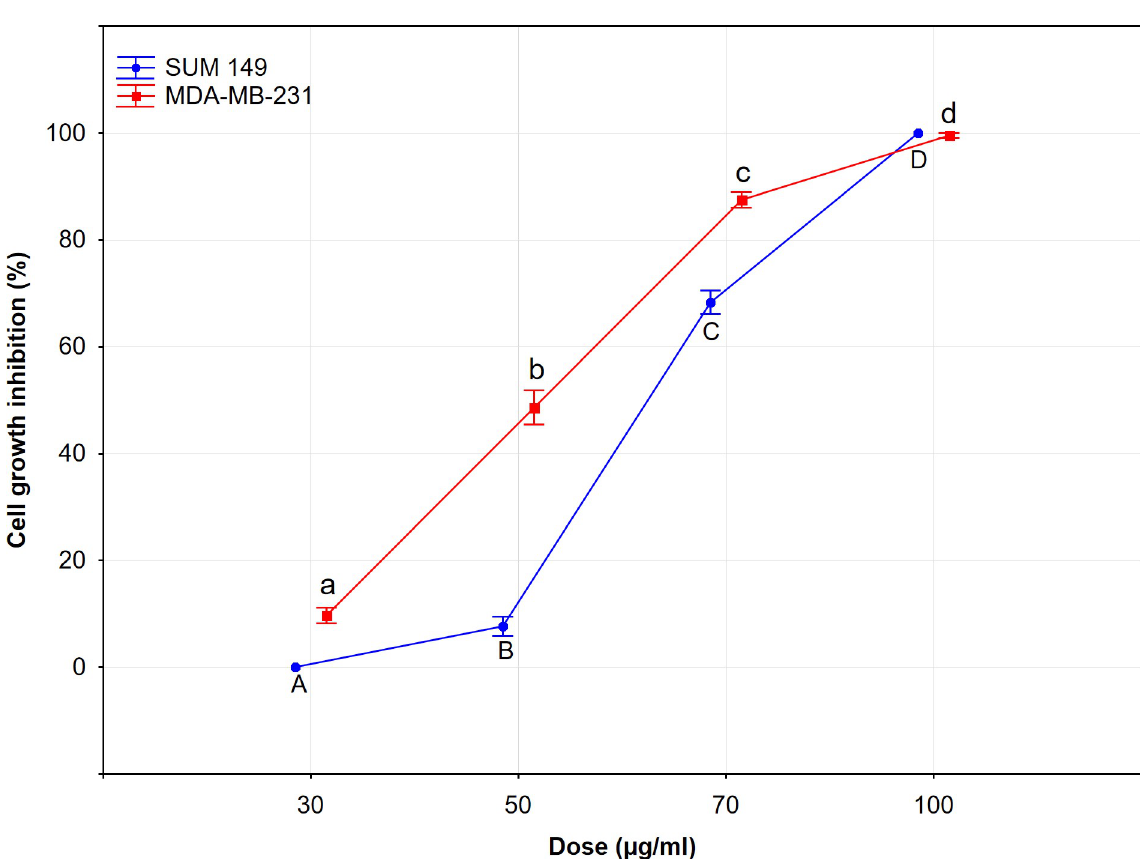
Fig 2. Cytotoxic activity of C . juttae essential oil on cancer cell lines. Cell viability was assessed by MTS. Data are expressed as mean ± standard error (SE) of at least three different experiments performed in triplicate. Different letters represent significant differences in cytotoxic activity among the concentrations of each cell line (Tukey test, p < 0.05).